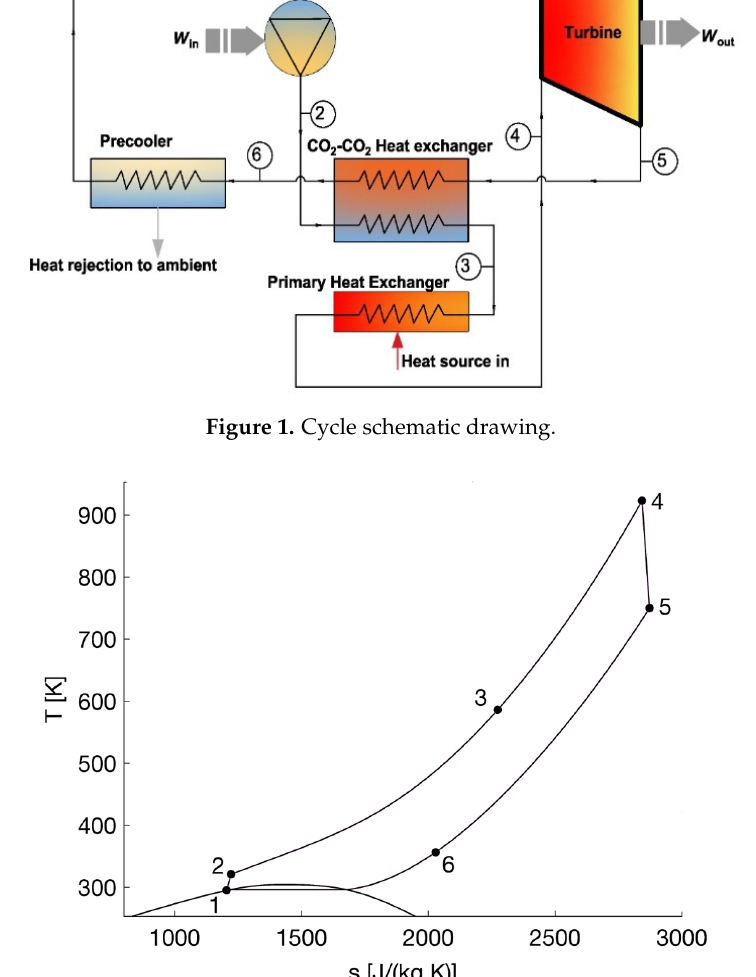
Figure 2. Entropy versus temperature ( T - s diagram) for the thermodynamic cycle in Figure